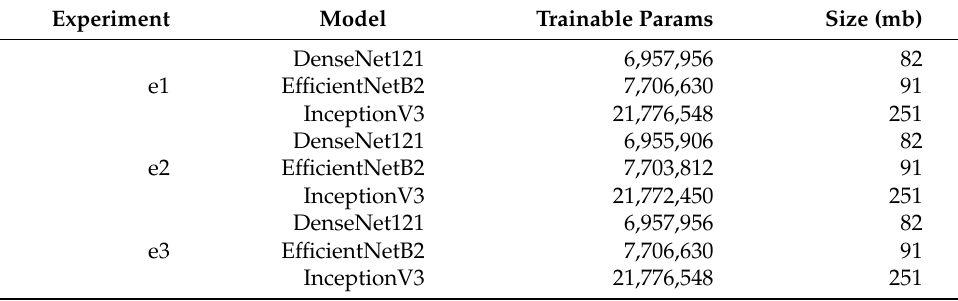
Table 2. Trainable parameters and size of the model.